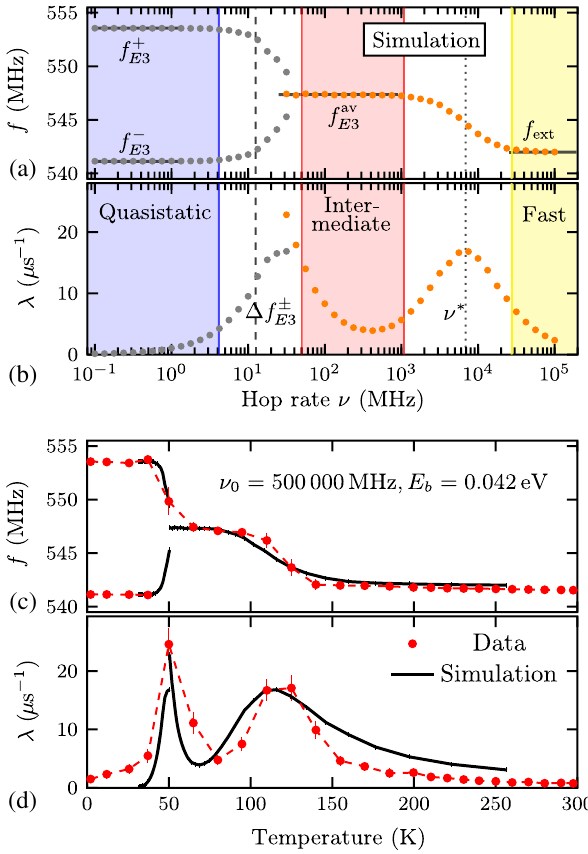
FIG. 12. Simulation of (a) precession frequencies and (b) re- laxation rate assuming hopping between adjacent muon sites arranged on a hexagon in 4 T, described by an exponential correlation time τ ¼ 1 = ν , where ν is the average hop rate. There are three different regimes: quasistatic (low hop rate), where the E 3 doublet is observed, intermediate hopping, where the average of the E 3 doublet is observed, and fast hopping, where internal fields are completely averaged out and a component at f predicted. (c),(d) Projection of the simulated values onto the obtained E 3 =E 3 0 =E 3 (cid:3) frequencies and relaxation rate assuming an Arrhenius-like activation. There is excellent qualitative agree- ment between the model and the data (see text for